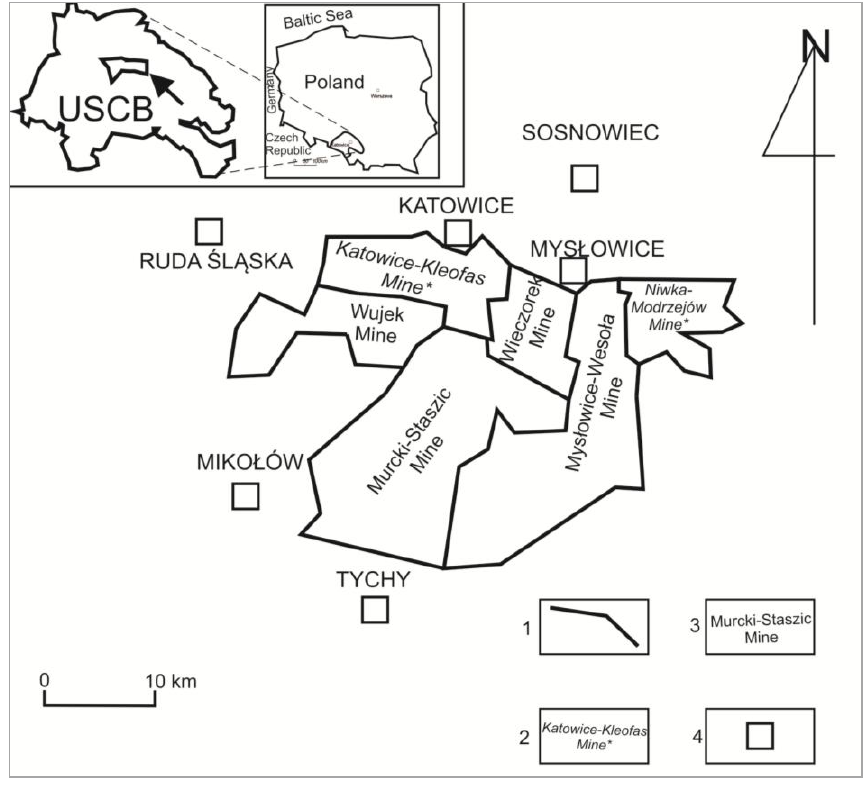
Fig. 1. Location of KCHC